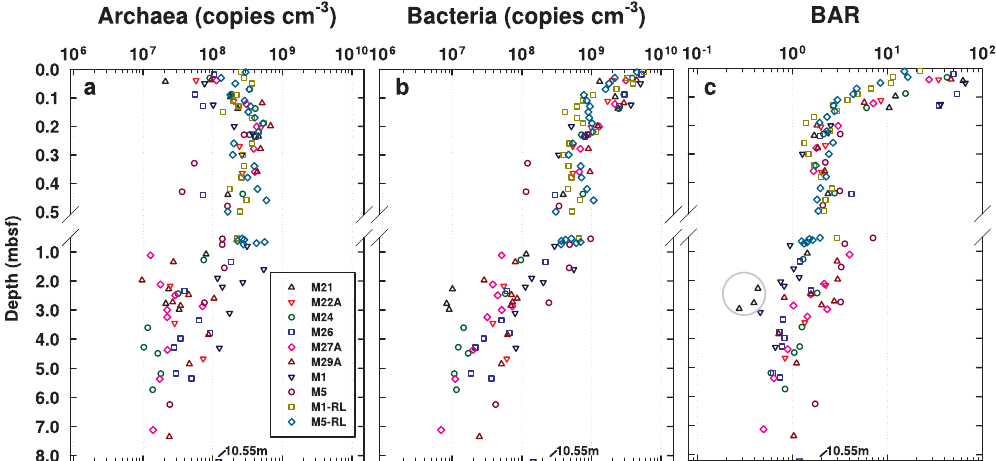
Figure 1. ( a ) Archaeal and ( b ) bacterial 16S rRNA gene copy numbers (copies cm − 3 wet sediment) and ( c ) BARs across a transect of eight stations in Aarhus Bay. The gray circle in ( c ) marks sediment samples from an organic-poor glacial sand layer at the bottom of M21. The SMTZ was reached at all stations except M21 and M22A, and varied greatly in depth and width (M24: 3.36–4.31 mbsf; M26: 2.04–3.78 mbsf; M27A: 2.62–2.90 mbsf; M29A: 2.20–2.75 mbsf; M1: 1.40–1.60 mbsf; M5: 0.47–0.58 mbsf). Free methane gas was detected at five stations (M26: ≥ 7.04 mbsf, M27A: ≥ 4.70 mbsf; M29A: ≥ 4.45 mbsf; M1: ≥ 4.00 mbsf; M5: ≥ 1.00 mbsf). Gravity and Rumohr cores were taken from M21, M22A, M24, M26, M27A, M29A, and M5 in May 2010, and from M1 in October 2009. Additional, increased sample-resolution Rumohr cores from M1 (M1-RL) and M5 (M5-RL) were obtained in March